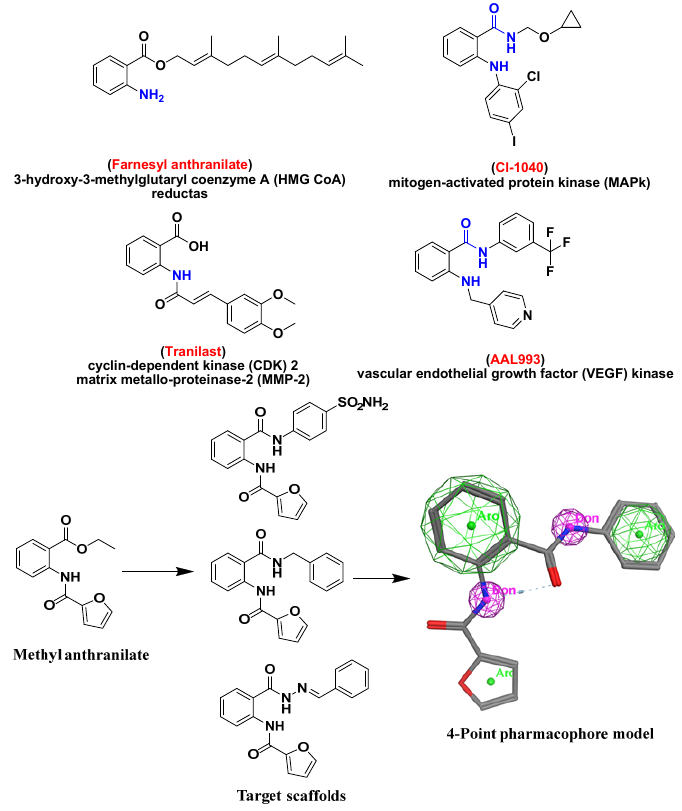
Figure 1. 4-Point pharmacophore model of the target compounds shows the pharmacophoric group that formed from two aromatic rings and two hydrogen bond donors amino groups (2NH) surrounded by 4 electronic networks having different polarity. Green color indicates low polar area, pink color indicates high polar area and blue color indicates mild polar area.